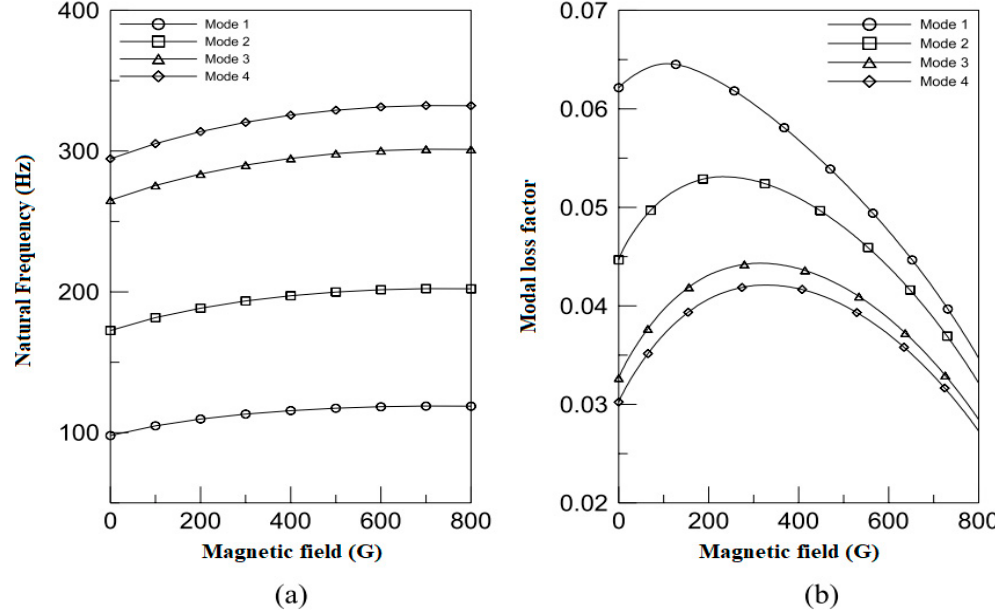
Figure 13. Effect of magnetic field on ( a ) natural frequency and ( b ) modal loss factor of the orthotropic sandwich plate system [102].